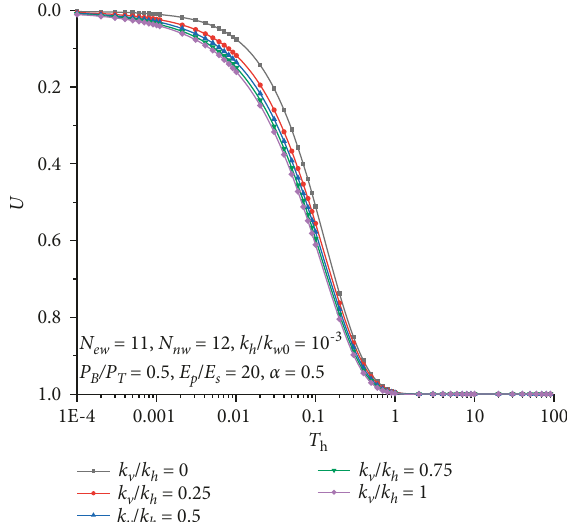
Figure 9: Influence of k H / r